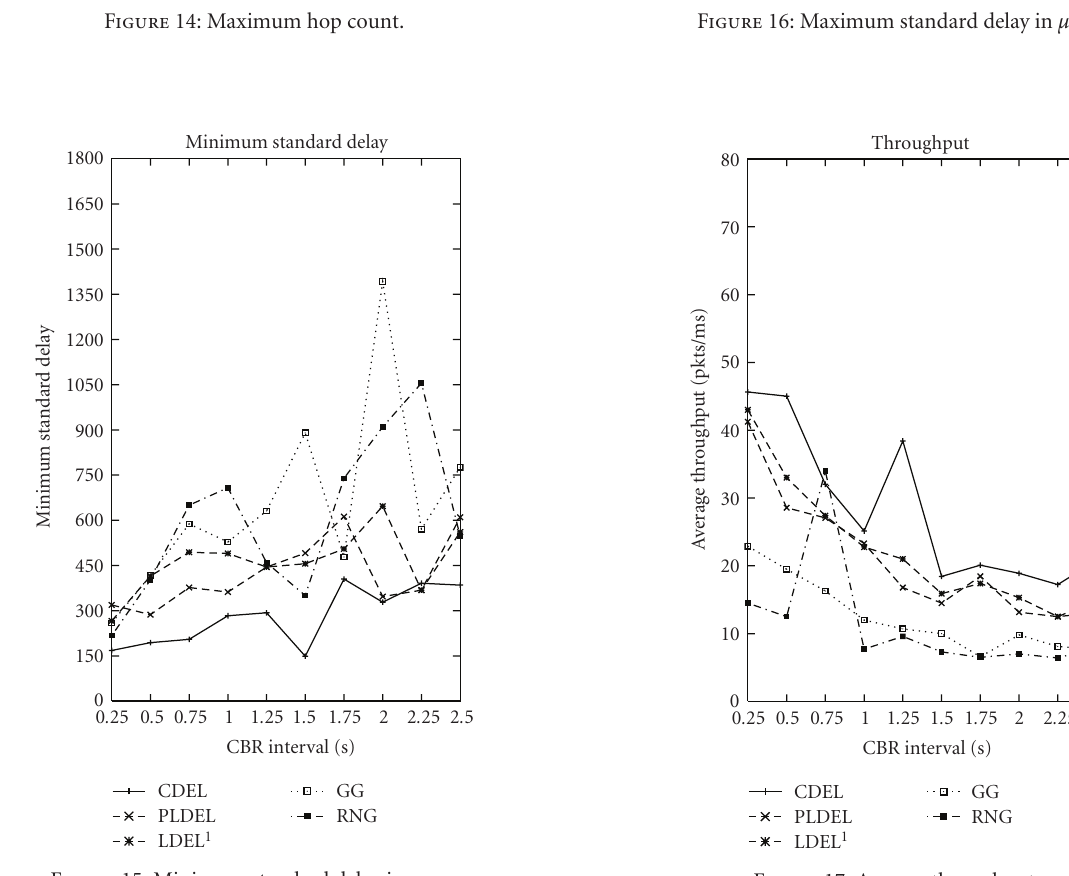
Figure 17: Average